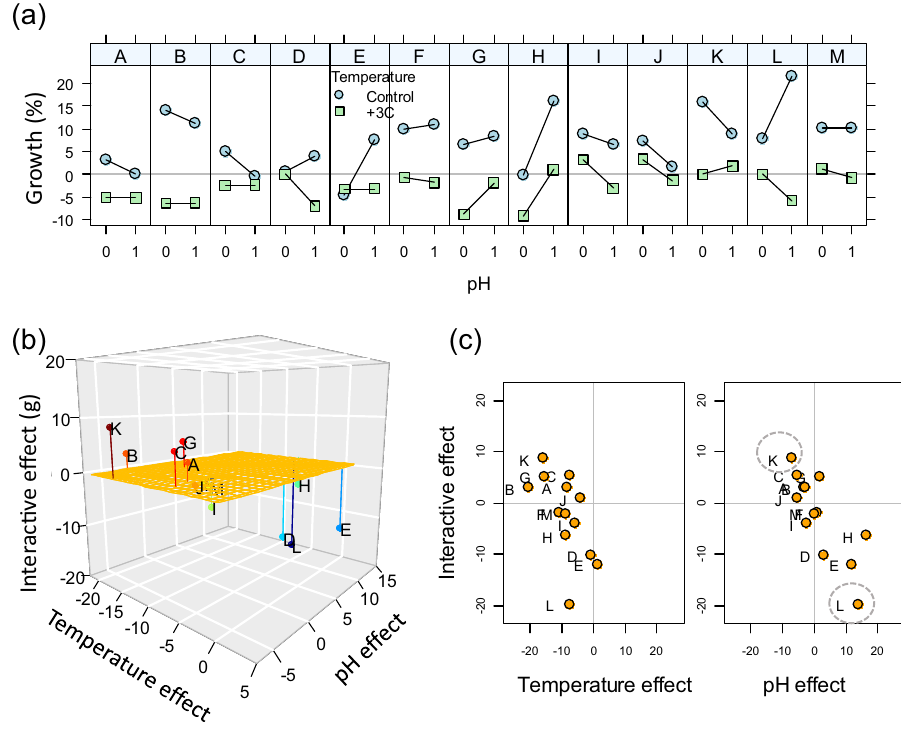
Fig. 3 Combined effects of temperature and pH on average growth of 13 genotypes of a marine bryozoan (source: Durrant et al. 39 , Fig. 2). a Interaction plots of means by colony (colonies: A – M): pH levels are: 0: pH = 8.1 (control); 1: pH = 7.8. State-space representations are given as ( b ) 3D plot and ( c ) 2D projections for the planes de fi ned by the interactive effect, and that of pH and temperature separately; there is a third projection for the plane de fi ned by the effect of pH and temperature that is not shown here. Each point in ( b , c ) is calculated from the four averages represented in ( a ). The negative effect of increased temperature on growth observed in ( a ) and found by Durrant et al. 39 , is seen in ( b , c ) as most colonies being towards the negative side of the temperature axis. The variability in responses among genotypes (interaction genotype:pH:temperature) is well appreciated (e.g. compare colony L with K) as variations in ( 1 ) whether the effect of reduced pH varies between negative and positive; hence, two drivers can operate as a double negative (K) or in different directions. ( 2 ) Whether the response is synergistic (K) or antagonistic (L). Data, details on methods and a representation of the full data set of Durrant et al. 39 Fig. 2. is found in the